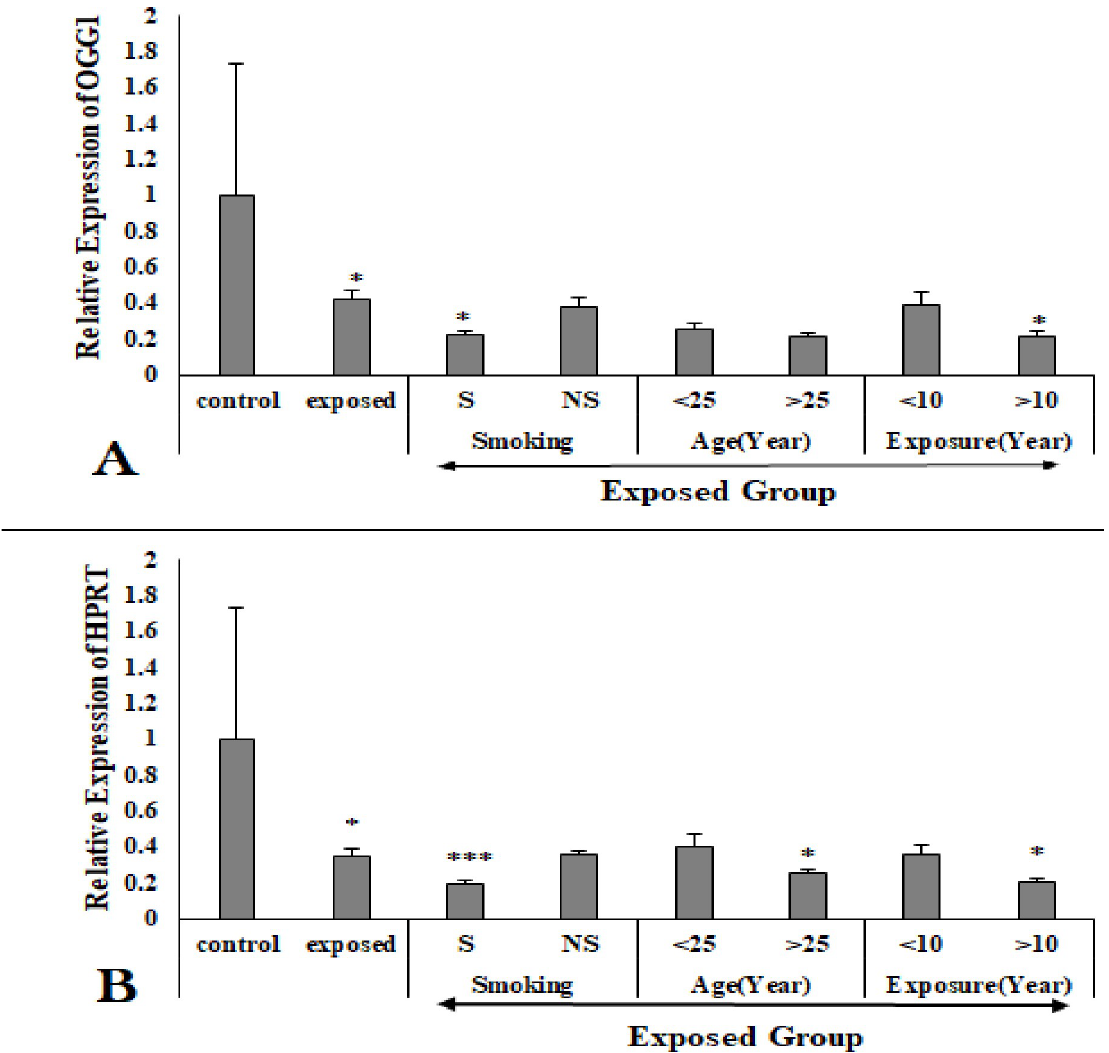
Fig 4. Relative expression of OGG1 (A) and HPRT (B) gene in control and exposed workers. S = smoker, NS = non-smokers. � P < 0.05, �� P < 0.01, ��� P <